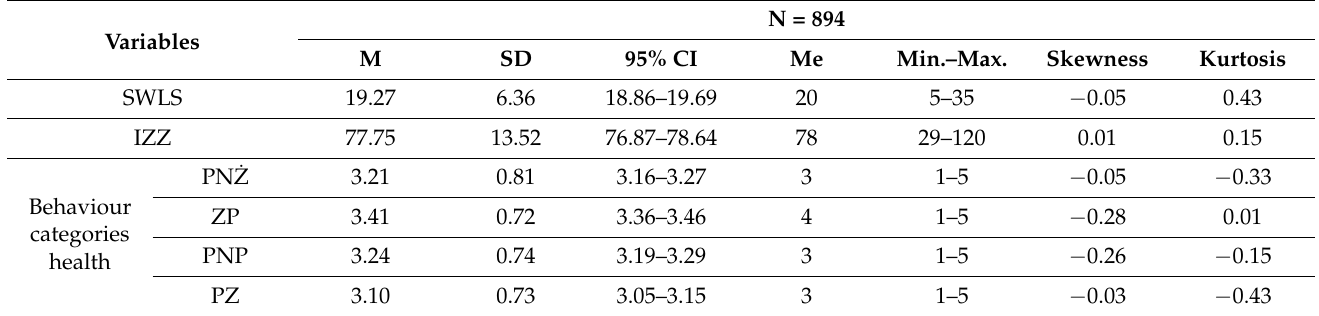
Table A1. Descriptive statistics of the variables under